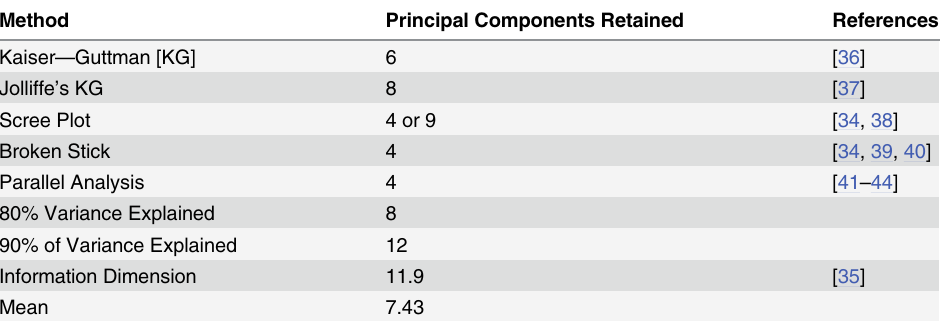
Table 1. Evaluation of the number of principal components to retain for factor analysis of 18 social vulnerability indicators using eight commonly used evaluation techniques.